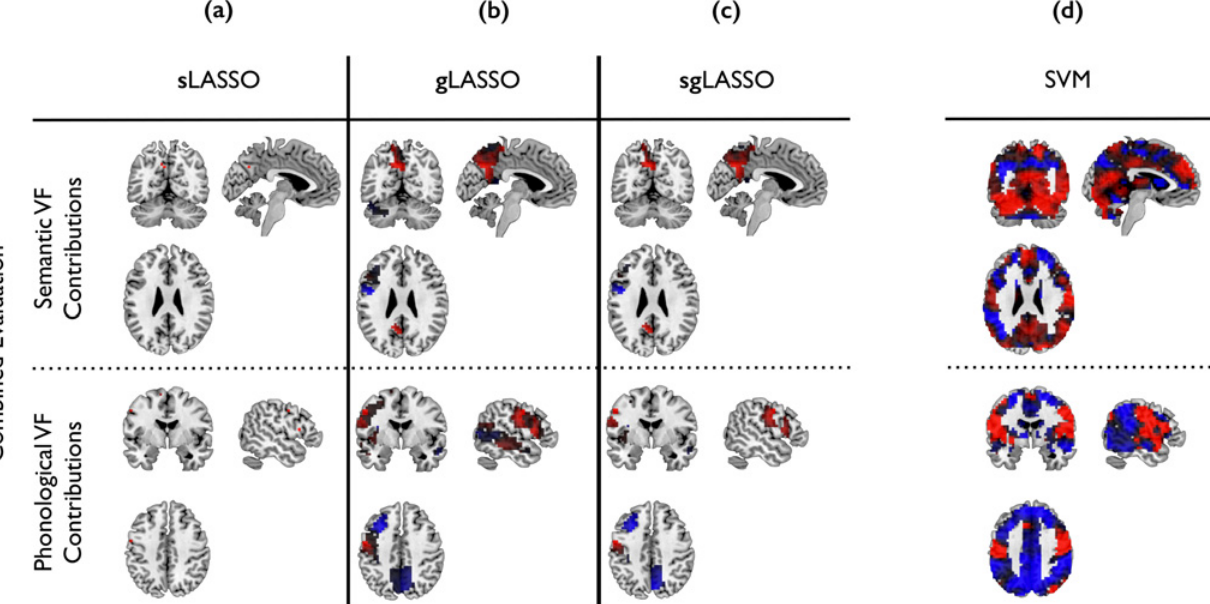
Fig 7. gLASSO constrains the number of groups of voxels (example combined dataset). This avoids the problem seen with sLASSO, where single voxels may erroneously suggest that brain areas containing those voxels distinguish between depressed and non-depressed patients. (a) For sLASSO, the number of non-zero weights is naturally sparse. Contributing voxels tend to be scattered, thus jeopardizing predictions in the case of even slight data distortion. (b) In gLASSO this is prevented by assigning voxels to groups. (c) sgLASSO further sparsifies contributing voxels within these groups, thus eliminating redundant weights, but preserving topological continuity. (d) The SVM algorithm uses all voxels to estimate the classification model (Plotted with mricron [30]). Positive weights are displayed in red, indicating voxels typically more highly activated in depressed subjects than in control subjects. Negative weights are displayed in blue, indicating voxels typically more highly activated in control subjects. Only voxels selected in more than 80% of the 1000 models evaluated in the hundred 10-fold nested cross-validation are displayed. Contributions in the evaluation of the separated datasets were similar to that of the combined evaluation, but less stable with respect to selection frequency in the cross validation models (see Fig 8).